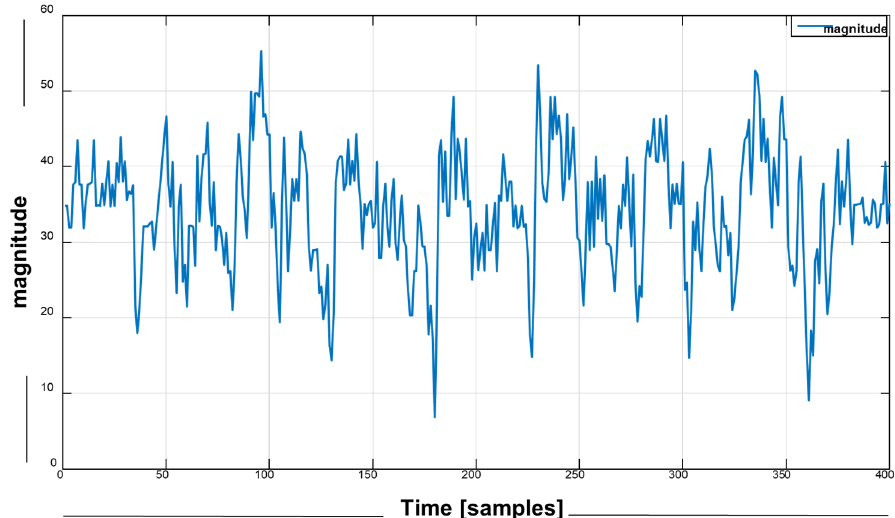
Figure 5. The instantaneous vector magnitude for the walking signal pattern from accelerometer sensor.